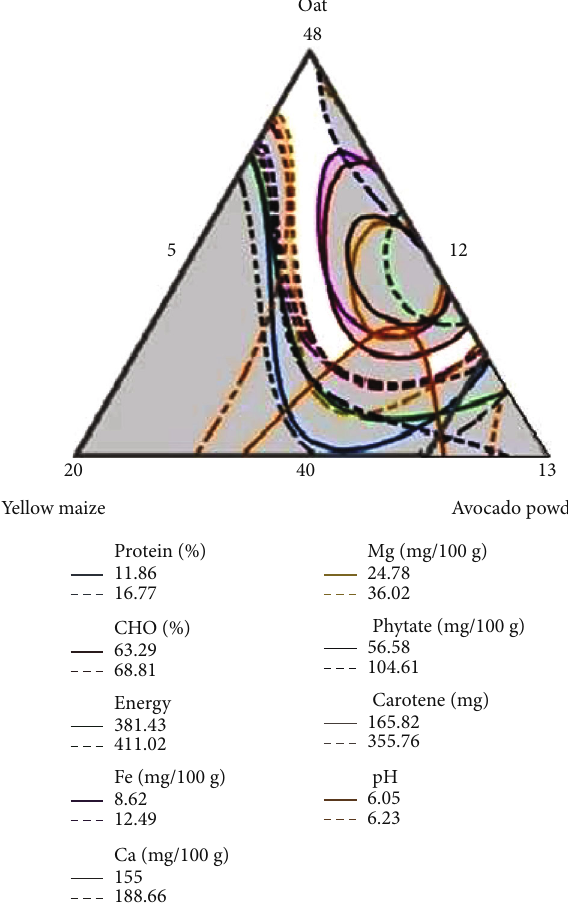
Figure 1: Overlaid contour plots that show the sweet spot. Notes: the white area shows the “ sweet spot ” that optimizes the response variables listed in the respective